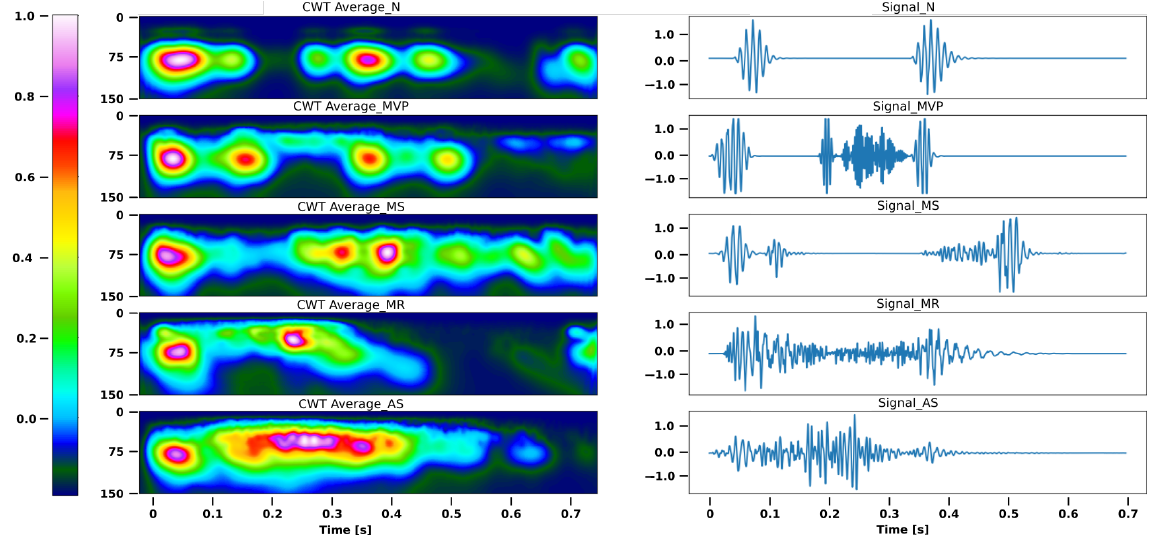
Figure 4. CWT results: The graph on the left shows, in a colorimetric scale, the value of the coefficients obtained for each scale at each time point, averaged for each of the class sets, with 150 scales. The graph on the right shows a normalized PCG record, randomly selected from each of the